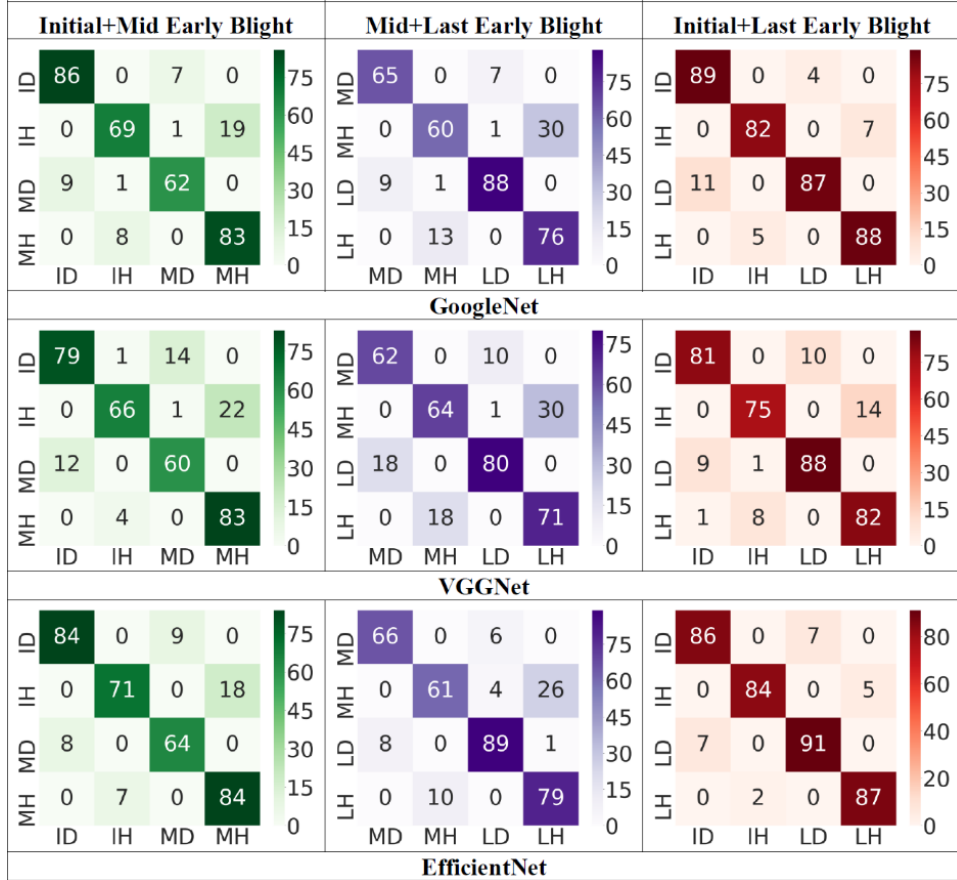
Figure 4. Confusion matrices of four class convolutional neural networks, where IH = number of actual and predicted initial healthy plants; ID = number of actual and predicted initial diseased plants; MH = number of actual predicted mid healthy plants; MD = number of actual and predicted mid diseased plants; LH = number of actual and predicted healthy plants; LD = number of actual and diseased